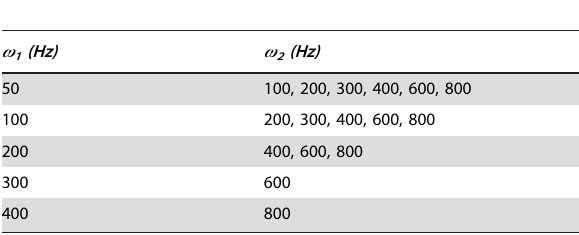
Table 1. Low- and high-frequency cut-offs for noise